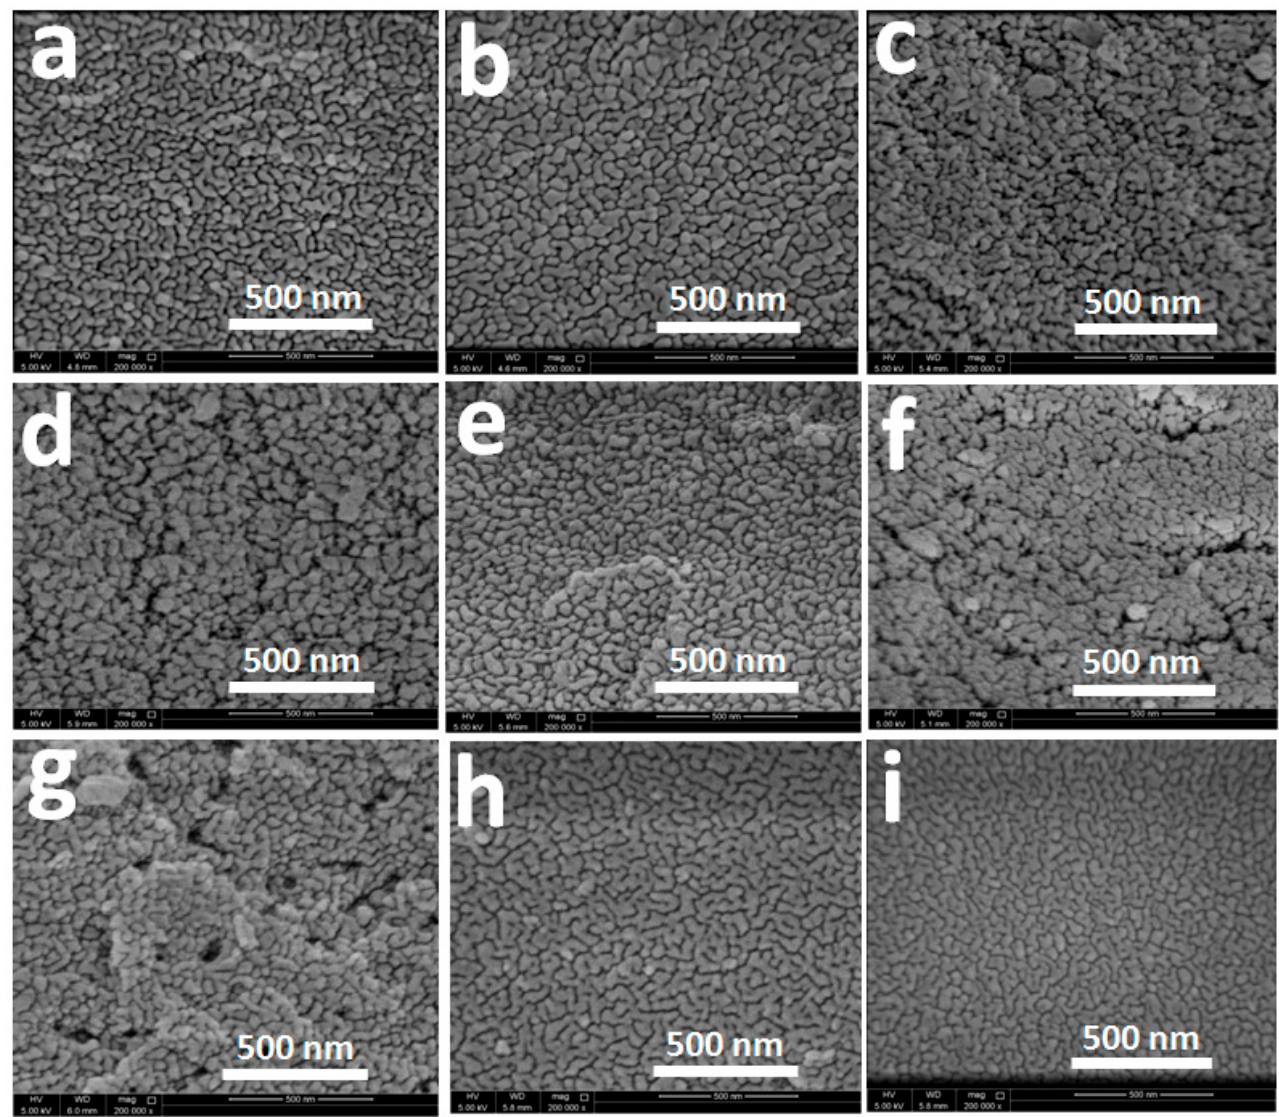
Figure 12. NanoSEM photo micrographs of ( a ) RFG1-AC, ( b ) RFG2-AC, ( c ) RFG3-AC, ( d ) RFG4-AC, ( e ) RFG5-AC, ( f ) RFG6-AC, ( g ) RFG7-AC, ( h ) RFG8-AC and ( i ) RFG9-AC samples.